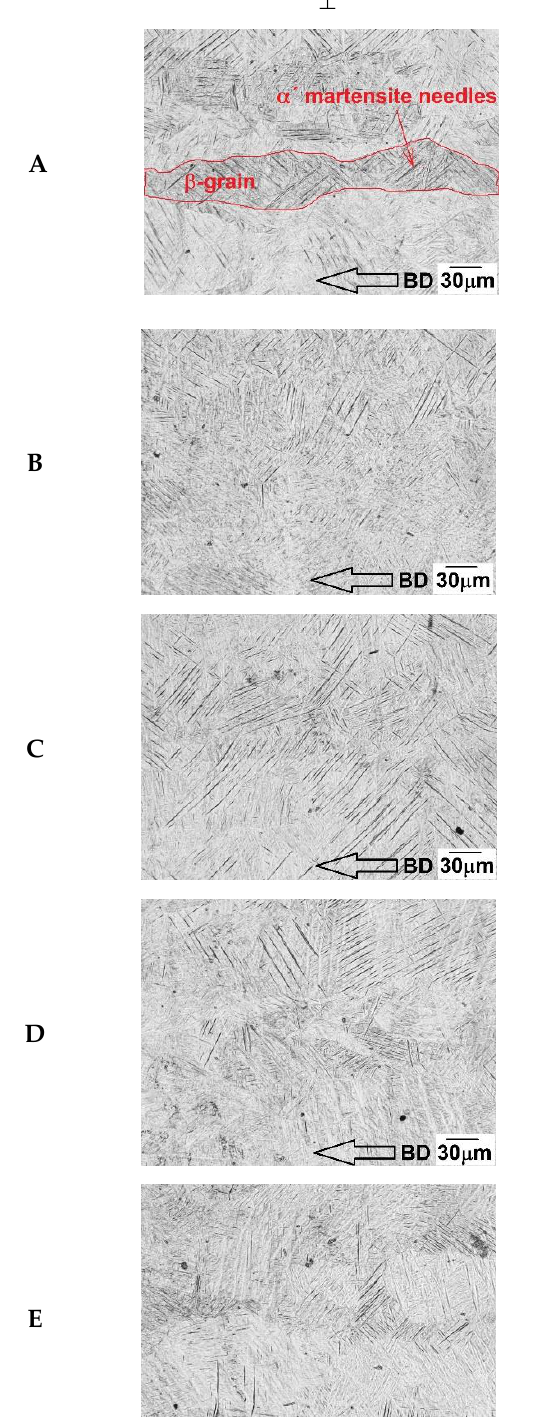
Figure 3. Micrographs of material in individual positions ( A – E ) and directions ( ⊥ and ‖ ), light microscope (LM), the arrow indicates build direction (BD).